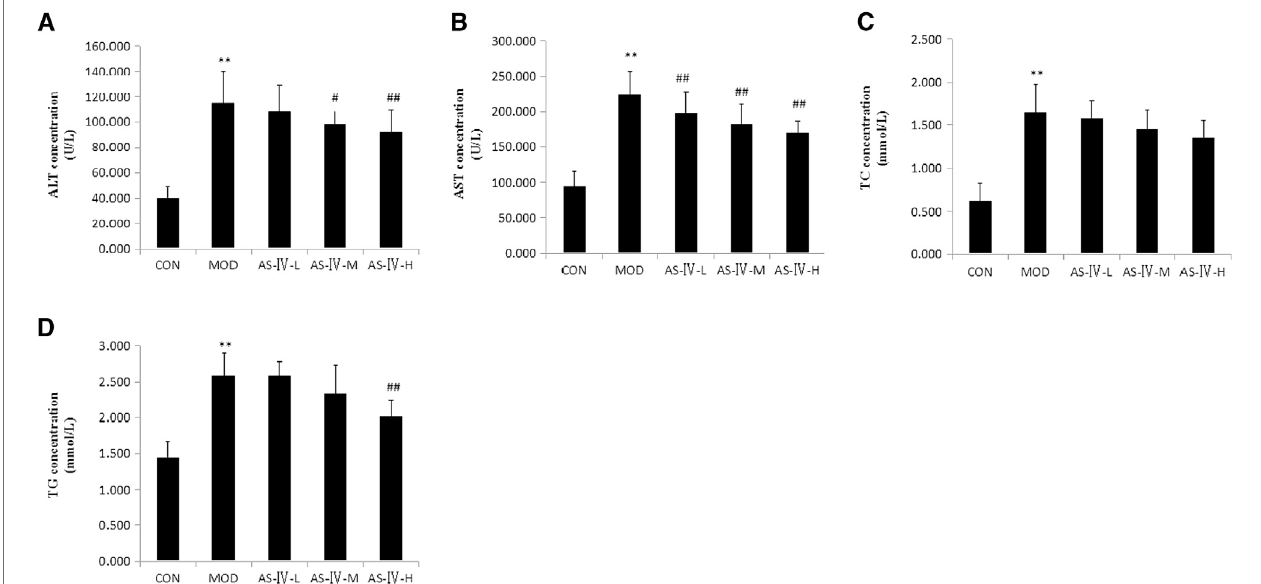
FIGURE 3 | Effects of astragaloside IV on biochemical parameters in HFD-fed rats. CON: 10 SD rats fed with normal diet for 12 weeks and then treated with intragastric administration of saline (1.0 ml/kg/day) and normal diet for 4 weeks. MOD: 10 SD rats fed with HFD for 12 weeks and then treated with intragastric administration of saline (1.0 ml/kg/day) and HFD diet for 4 weeks. AS-IV-L: 10 SD rats fed with HFD for 12 weeks and then treated with intragastric administration of 20 mg kg − 1 day − 1 andHFDfor4 weeks.AS-IV-M:10SDratsfedwithHFDfor12 weeksandthentreatedwithintragastricadministrationof40 mg kg − 1 day − 1 and HFDfor4 weeks.AS-IV-H:10SDratsfedwithHFDfor12 weeksandthentreatedwithintragastricadministrationof80 mg kg − 1 day − 1 andHFDfor4 weeks. (A) Serum ALT concentration of each group. (B) Serum ASTconcentration of each group. (C) Serum TCconcentration of each group. (D) Serum TG concentration of each group. Datapresent themean ± SD.Comparisonsbetweentwogroupsuse t- testsand datacomparisonamongmultiplegroupsuseone-wayANOVA.* p < 0.05and** p < 0.01 compared with the control group; # p < 0.05 and ## p < 0.01 compared with the model group. HFD, high-fat diet; ALT, alanine aminotransferase; AST, aspartate aminotransferase; TC, total cholesterol; TG, triglyceride; CON, control group; MOD, model group; AS-IV-L, astragaloside IV low-dose group; AS-IV-M, astragaloside IV middle-dose group; AS-IV-H, astragaloside IV high-dose